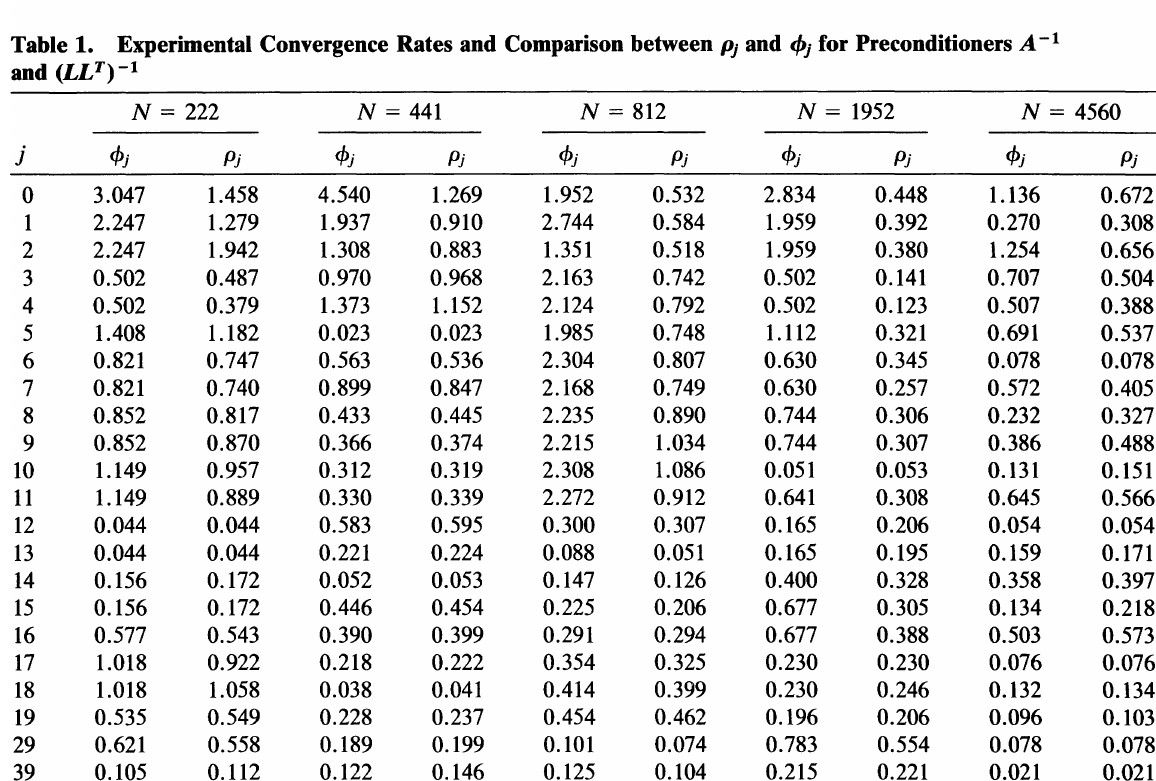
Comparison between theoretical asymptotic convergence rate CPj, Eq. (23), and the numerical convergence rate Pj of DACG with 13k = f3~l), and with K-I = A-I and K-I = (LLT)-I, respectively, for some of the leftmost eigenpairs of the five sample problems.